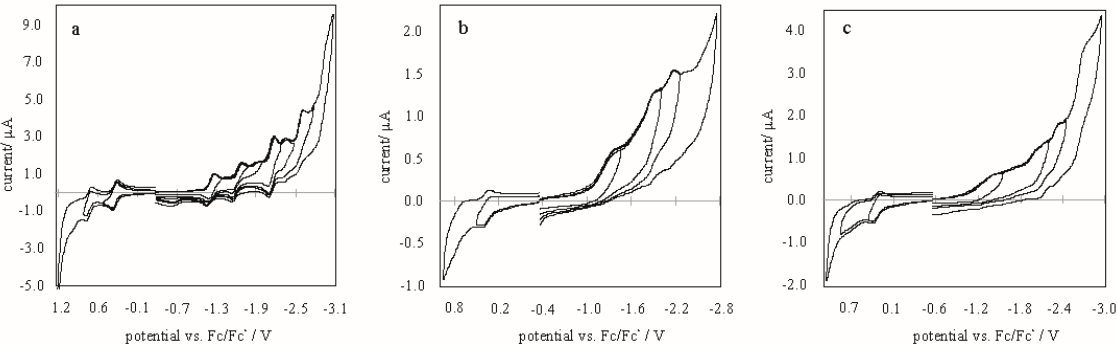
Figure 2. Cyclic voltammograms of 1 ( a ), 2 ( b ), 3 ( c ) in TBAPF 6 /(MeCN:Tol = 1:4, v / v ), at a scan rate of 50 mV · s − 1 .